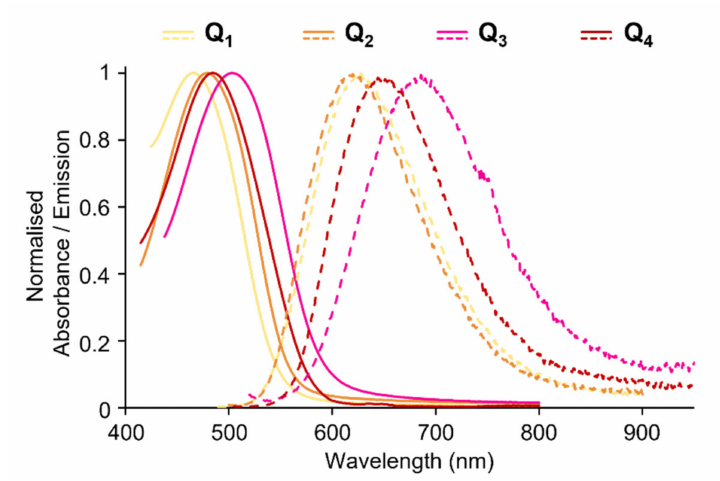
Figure 6. Absorption and emission spectra of FONs made from dyes Q1 – Q4 . The confinement of the quadrupolar dyes within FONs leads to a slight hypochromic shift of the ICT band. We note that this effect seems more pronounced in the case of Q 2 and Q 4 (Figure 7). On the other hand, no sign of excitonic coupling or splitting is observed, in contrast to previous observations on different quadrupolar derivatives built from a fluorene core [11]. This suggests that the four pendant alkyl chains extending above and below the π -conjugated systems hamper such phenomenon.